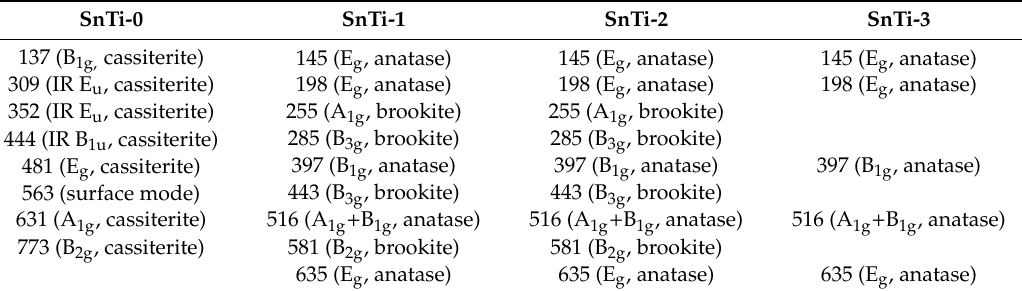
Table 2. Assignment of Raman vibrational modes (cm − 1